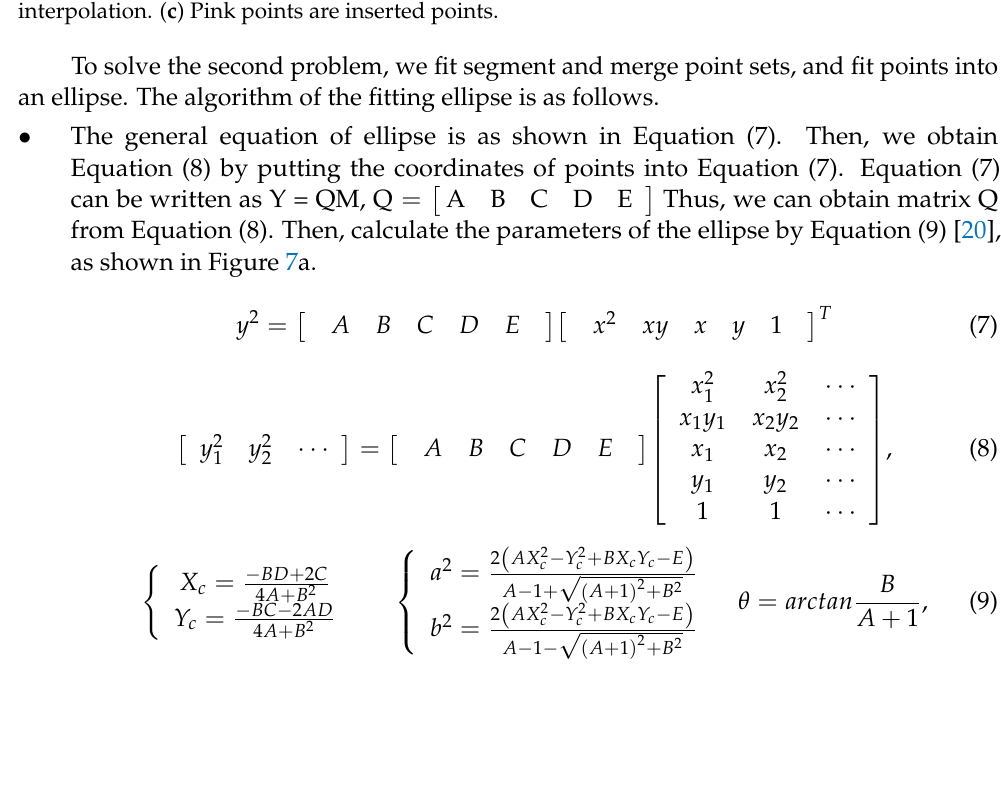
Figure 6. Points set. ( a ) Points in different set are marked in different color. ( b ) Points before interpolation. ( c ) Pink points are inserted